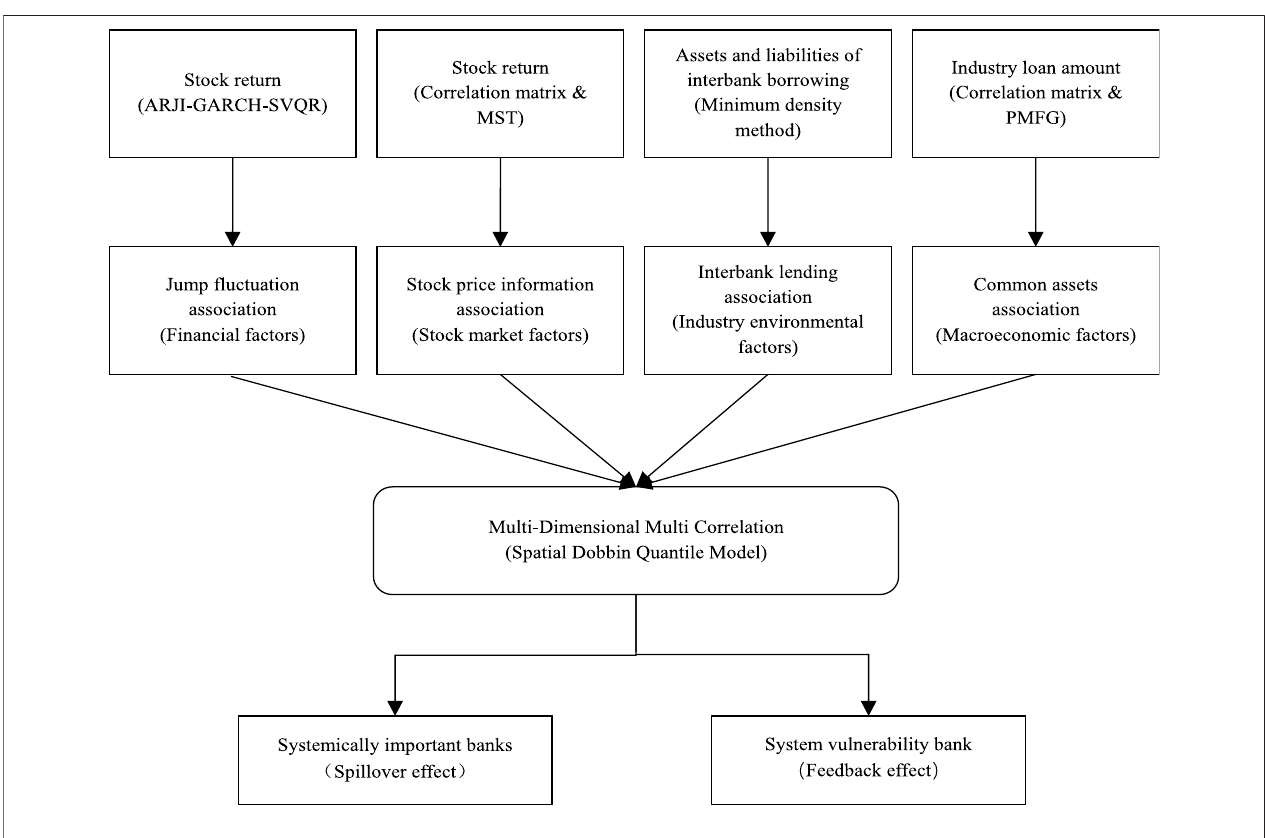
FIGURE 1 | MDMC contagion of bank